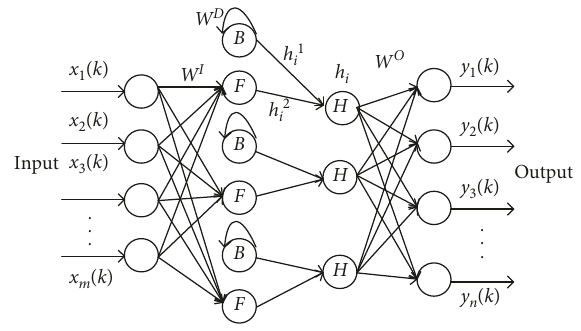
k the chaos controller output, and h 2 1 is the front hidden i ( ) layer output. f is the activation function with sigmoid (·) type. The weight matrixes of the input layer, neurons H layer, − and neuron thresholds are corresponding to ω I , ω O , and ω T , respectively. ω D is the chaotic coefficient given by the logistic